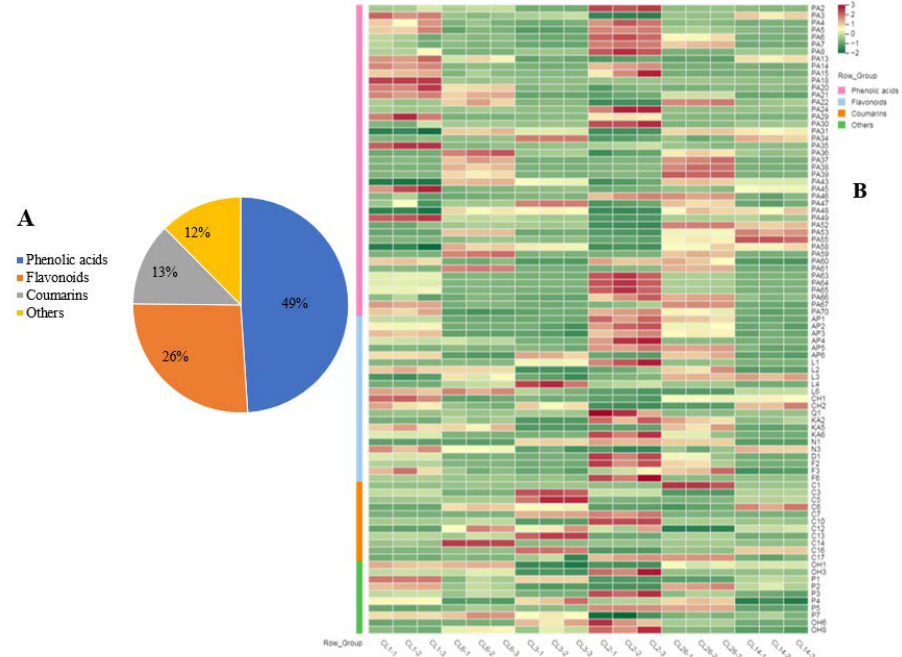
Figure 3. The classification of secondary metabolites ( A ) and the heatmaps of relative content of different secondary metabolites ( B ) in celery juice. All the relative contents normalized using z-score. The abbreviations of different volatile flavor compounds were show in Table S6.